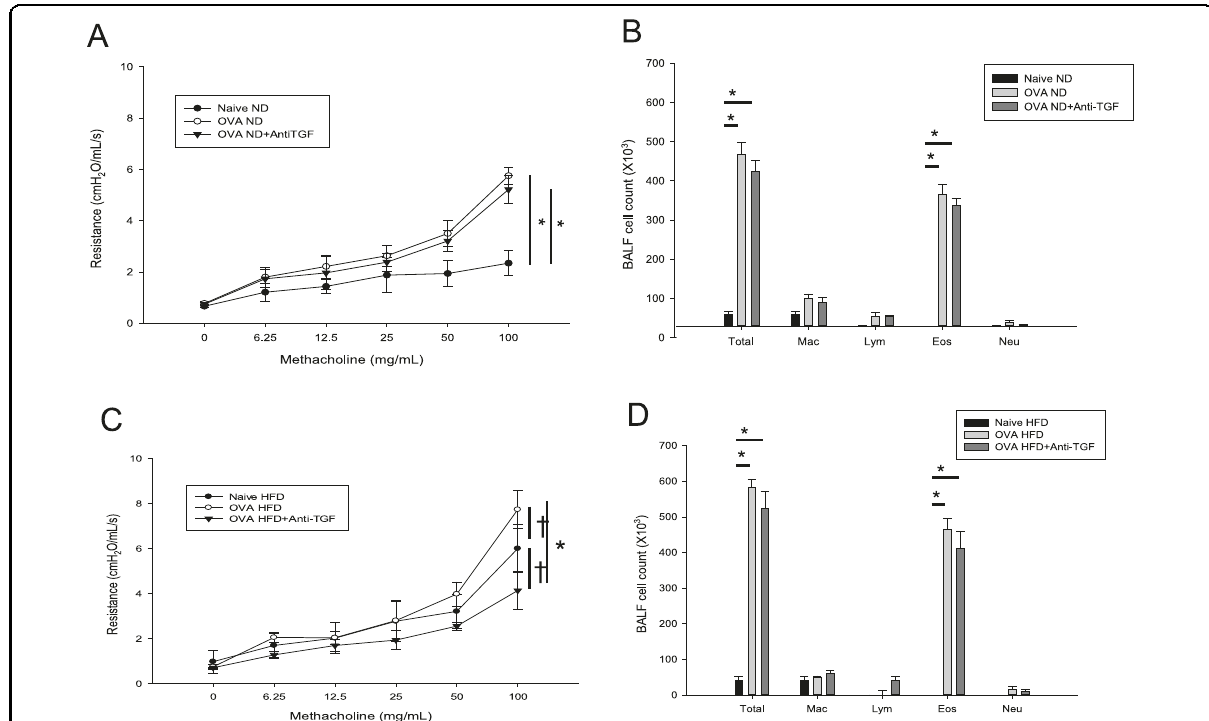
Fig. 5 Anti-TGF- β 1 treatment to ND or HFD mice with OVA allergic asthma model. Effects of anti-TGF- β mAb treatment on AHR to MCh and the in fl ammatory cell pro fi le of the BALF in OVA-ND ( a , b ) and OVA-HFD mice ( c , d ). ‡ P < 0.01; * P < 0.001. TGF transforming growth factor, AHR airway hyperresponsiveness, MCh methacholine, BALF bronchoalveolar lavage fl uid, HFD high-fat-diet, ND normal diet, OVA